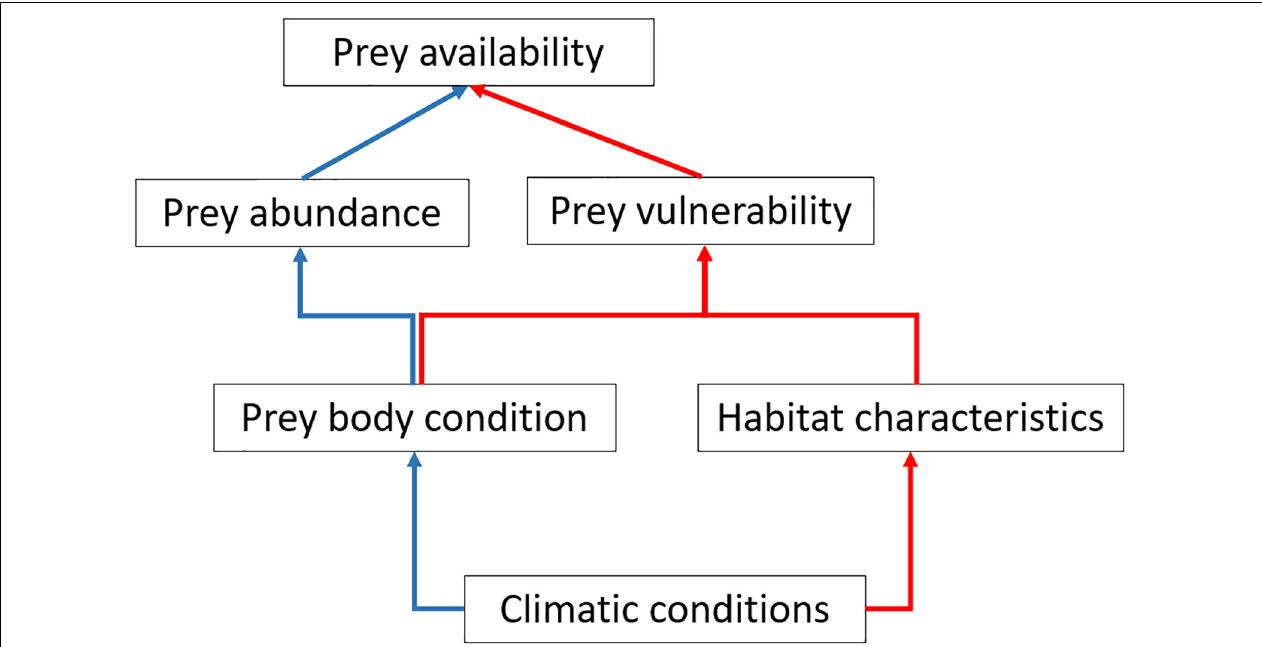
FIGURE 1 | The potential pathways by which climatic conditions can affect prey availability for predators. The blue arrows represent the links classically modelled in existing models (scenario 1 in this study). The red arrows represent the links originally modelled in this work (through scenarios 2–4).